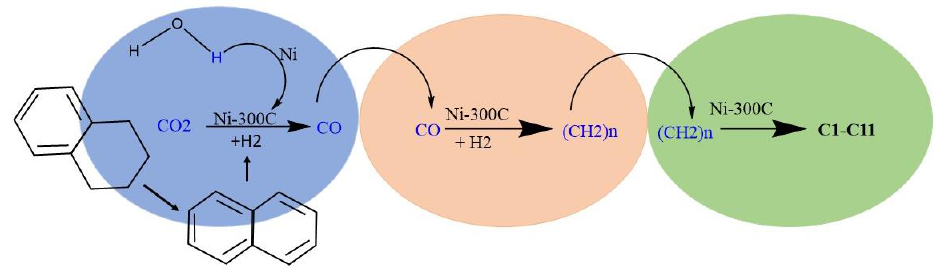
Figure 2. The proposed in situ hydrogenation of CO 2 into light n-alkanes. Table 1. The gas components which evolved after the noncatalytic and catalytic hydrothermal processes.